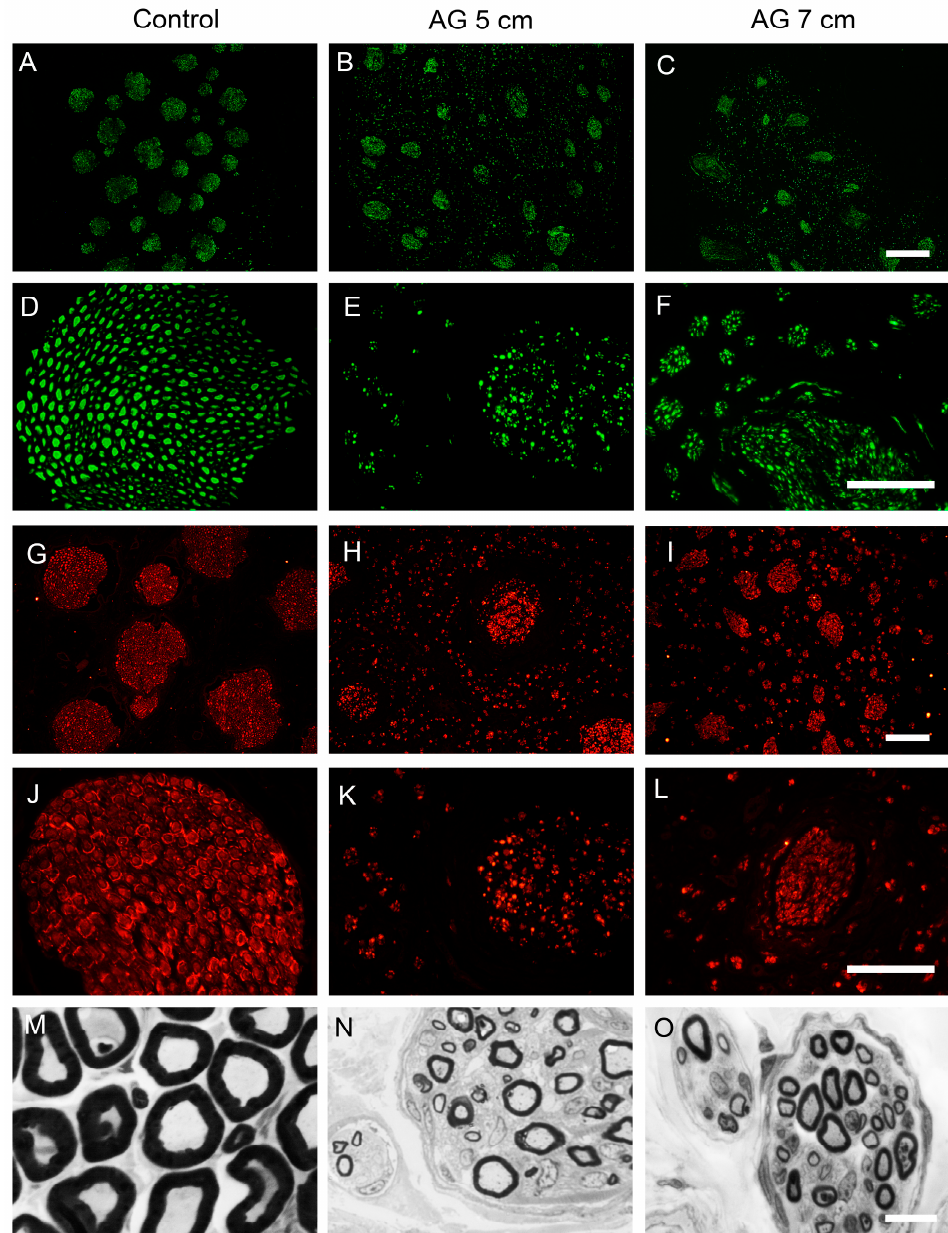
Figure 5. Representative immunohistochemical images of transverse sections of a control peroneal nerve ( A , D , G , J ) and of an autograft of group AG5 ( B , E , H , K ) and of group AG7 ( C , F , I , L ). Sections were immunolabeled against NF200 for myelinated axons ( A – F ), and against S100 for Schwann cells ( G – L ). Images were taken at × 40 magnification ( A – C , G – I ), scale bar 200 µ m, and at × 400 magnification ( D – F , J – L ), scale bar 100 µ m. The bottom panels show representative semithin transverse sections of the middle segment of the nerve graft stained with toluidine blue. ( M ) control nerve, ( N ) AG5, and ( O ) AG7 graft, at 10,000 × magnification, scale bar 10 µ